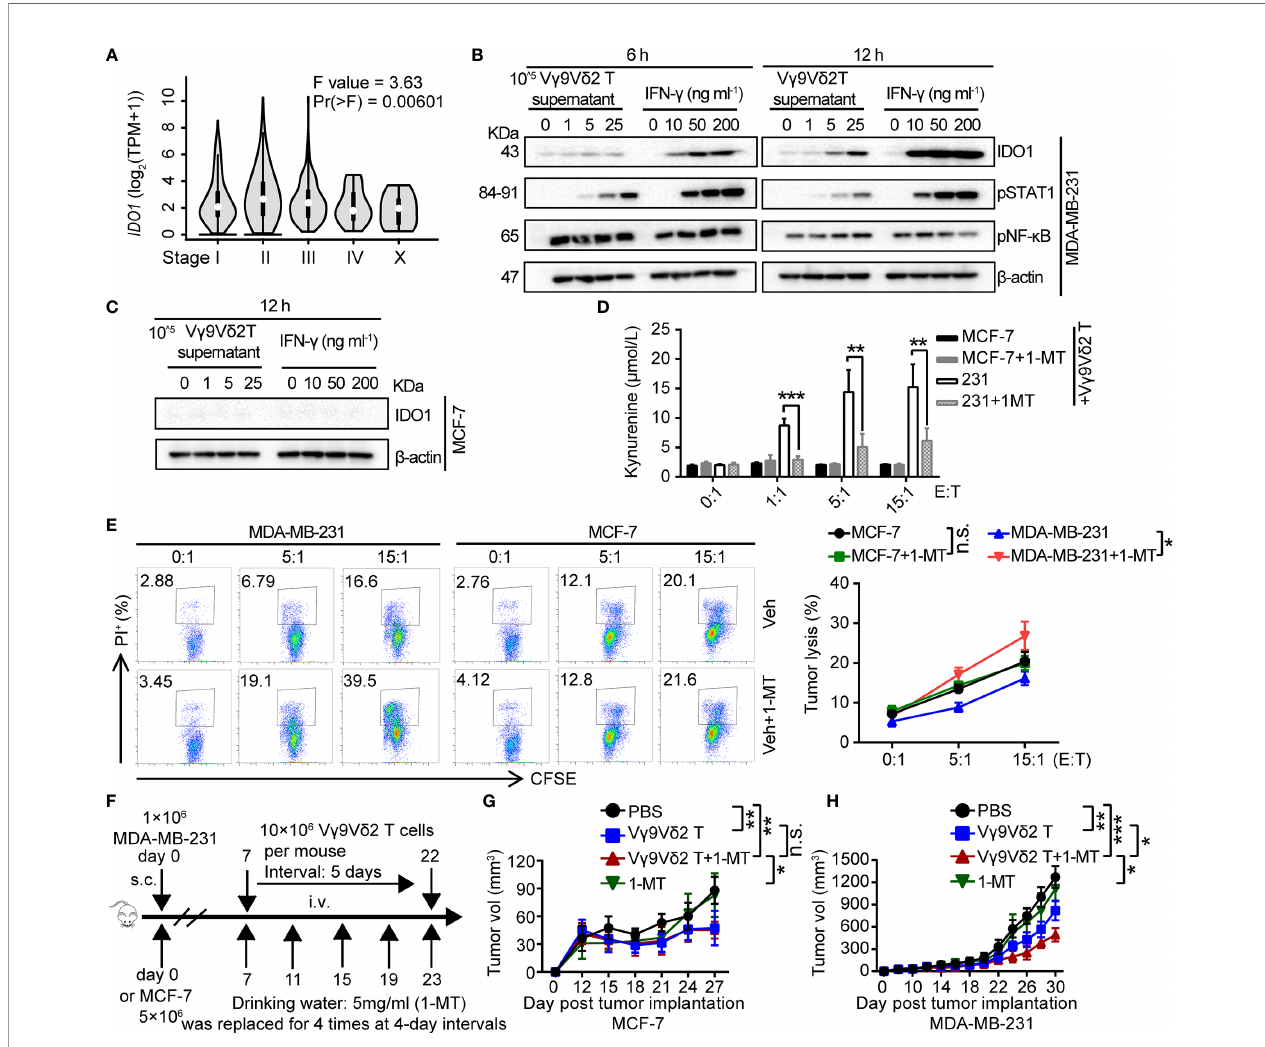
FIGURE 4 | 1-MT enhanced the antitumor ef fi cacy of V g 9V d 2 T cells. (A) Expression of IDO1 in BRCA at different pathological stages, (BRCA, n =1085). (B) MDA- MB-231 cells were treated with the culture medium of V g 9V d 2 T cells or IFN- g for 6, and 12 hours. Western blot to detect IDO1, p-STAT1, and p-NF- k B expression; b -actin was used as the loading control. (C) MCF-7 cells were treated with culture supernatant of V g 9V d 2 T cells or IFN- g for 12 hr. Western blot to detect IDO1 level; b -actin was used as the loading control. (D) Kynurenine was the metabolite of L-tryptophan catalyzed by IDO1 enzyme, and its level in the culture supernatant of MCF-7 and MDA-MB-231 cells cocultured with V g 9V d 2 T cells treated with or without 1-MT was shown. The amounts of kynurenine were measured by ELISA kits. (E) IDO1 inhibitor 1-MT facilitated the cytotoxicity of V g 9V d 2 T cells toward MDA-MB-231 cells, but not MCF-7 cells. MCF-7 or MDA-MB-231 cells (target) were co-cultured with V g 9V d 2 T cells (effector) with 1-MT or vehicle for 6 hours. The percentage of dead cells out of total target cells was shown. (F – H) Schematic protocols of tumor growth model (left). n =5 mice per group. Experiments were independently repeated three times (H, I) . Results in (C, D) were representative blots from 2 to 3 independent experiments. V g 9V d 2 T cells from healthy donors were expanded with ZOL. Data represent mean ± SD (E, F, H, I) . Unpaired two-tailed Student ’ s t -test (E, F) ; one-way ANOVA using the disease state (tumor or normal) as variable for calculating the differential expression of IDO1 (A) ; The method for IDO1 expression analysis was one-way ANOVA by using the pathological stage as variable for calculating differential expression (B) ; two-way ANOVA (H, I) . Signi fi cance was set to P < 0.05 and represented as * P < 0.05, ** P < 0.01, *** P < 0.001, and **** P < 0.0001, n.s. , not signi fi